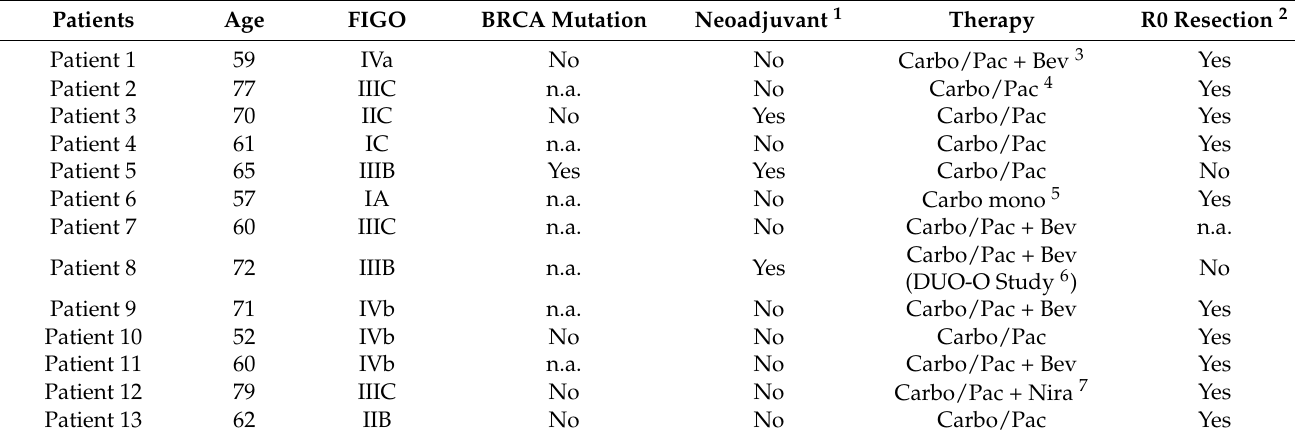
Table 1. Clinical characteristics of high-grade serous ovarian cancer